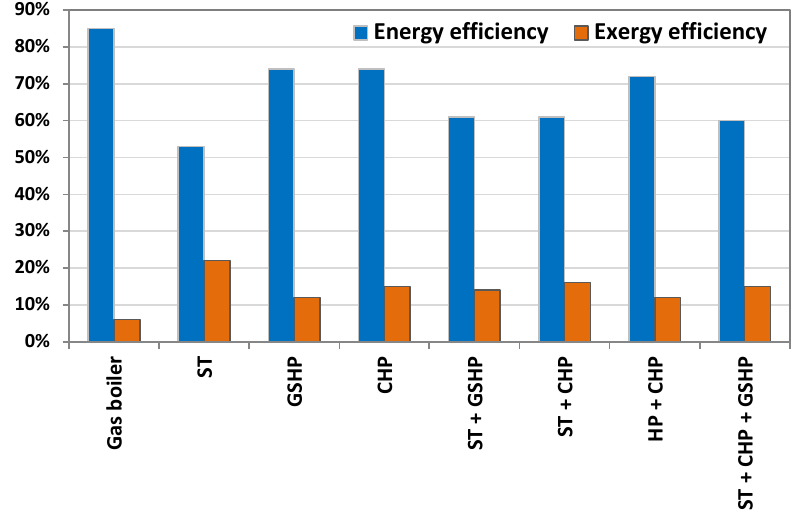
Figure 13. Energy and exergy efficiency for different combinations of heating systems (from [45]): ST = solar thermal collectors; GSHP = ground source heat pump; CHP = combined heat and power